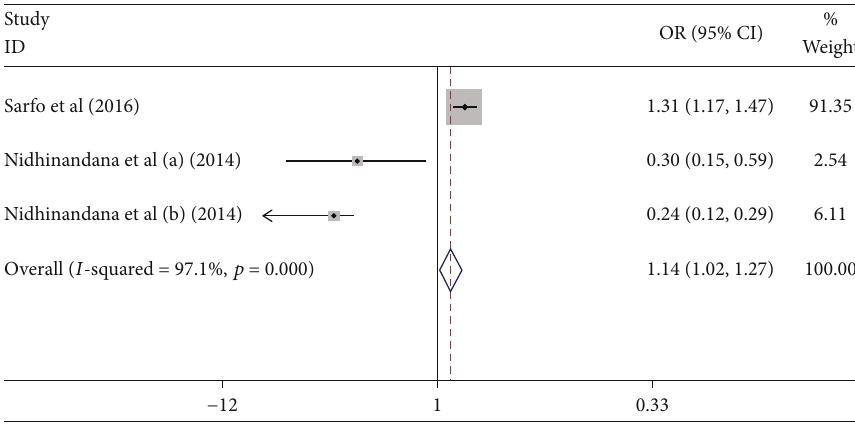
Figure 6: E ff ect size of hypertension stage on the uncontrolled hypertension. Funnel plot with pseudo 95% confidence limits